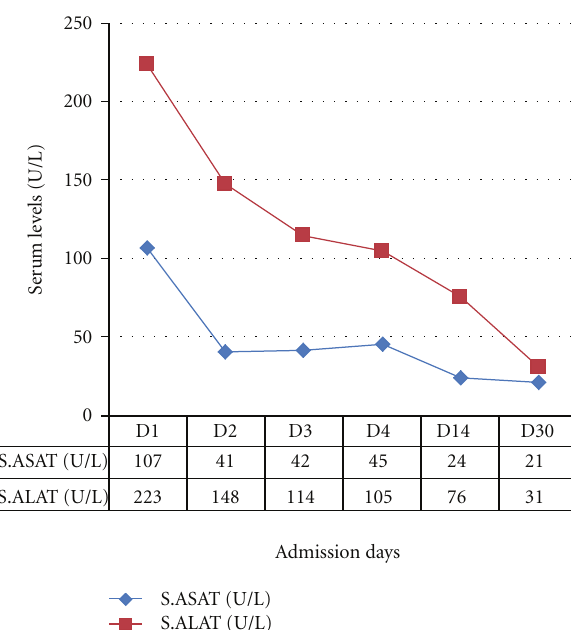
Figure 1: Profile of serum CRP (mg/L), clozapine, and norclozapine (measured in μ g/L, changed to mg/L and then multiplied by 100 for ease of viewing) levels during admission.